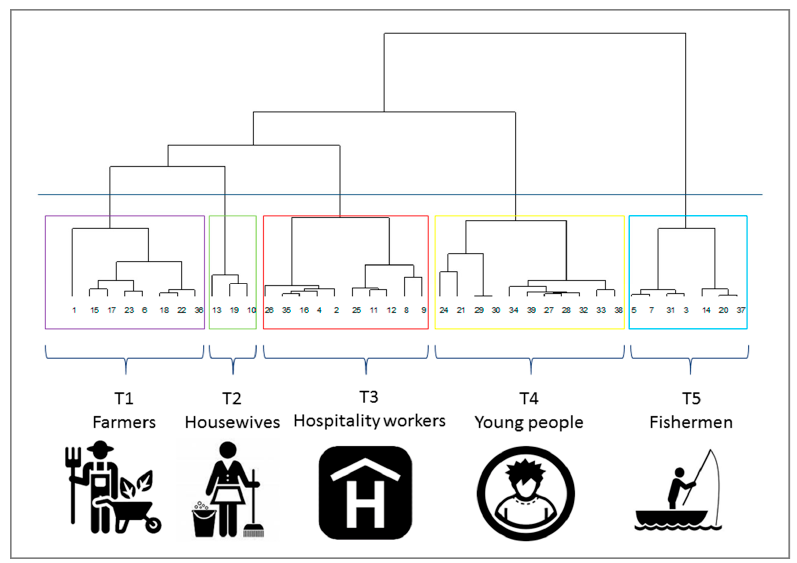
Figure 4. Dendrogram of the hierarchical cluster analysis calculated from the first 7 axes of the MCA. The five groups of social actors are differentiated, and their main discriminant variables are